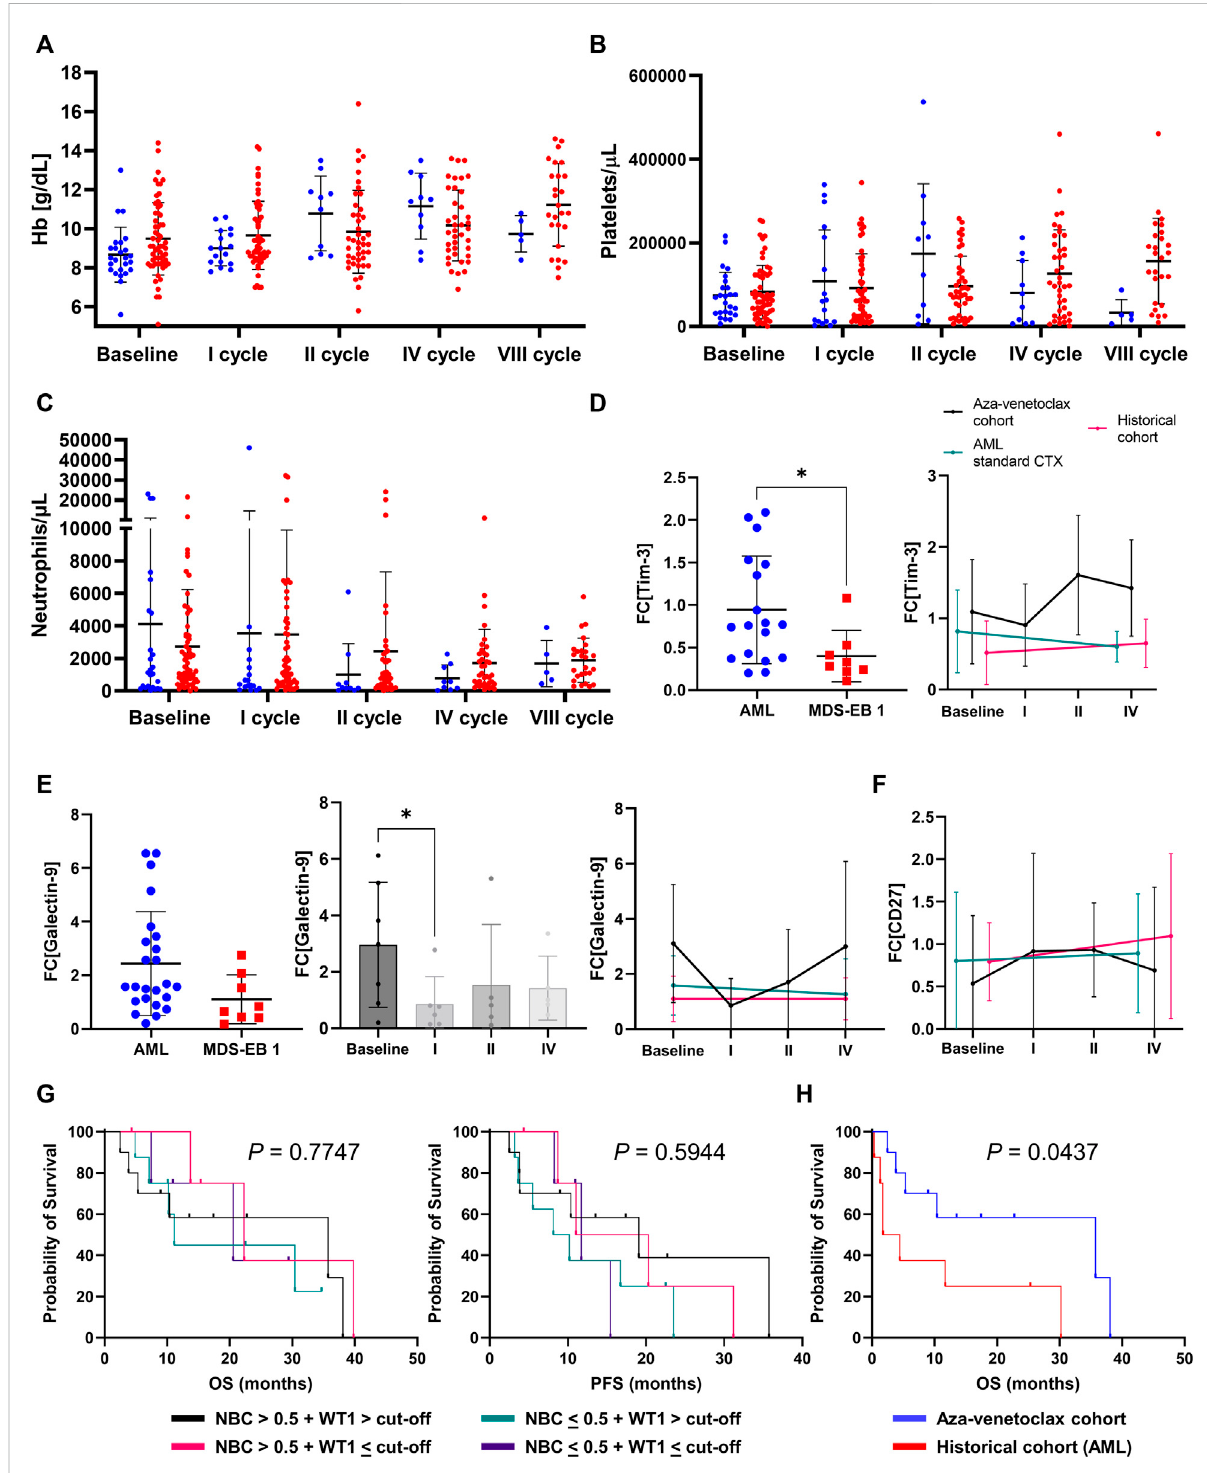
FIGURE 3 Laboratory parameters and prognosticators (A) hemoglobin (Hb) levels (B) platelets count, and (C) absolute neutrophil count variations at baseline and during treatment in azacytidine plus venetoclax (aza-venetoclax cohort) or to azacytidine as single agent (historical cohort) groups are reported (D) differences inTim-3 expression [reportedas fold-change(FC) to healthy controls] based ondisease[acutemyeloid leukemia (AML) and high-risk myelodysplastic syndromes (MDS) vs. MDS with excess of blast of type 1 (MDS-EB 1)] or treatment type [azacytidine + venetoclax vs. azacytidine alone vs. standard chemotherapy (CTX)]. Similarly (E) galectin-9 and (F) CD27 FC variations are displayed based on disease type and during treatment (G) Overall survival (OS) and progression-free survival (PFS) are reported for patients treated with azacytidine plus venetoclax divided by normalized WT1 expression levels and fl ow cytometric normalized blast count (NBC) values (H) OS of patients with WT1 > cut-off (50 copies in peripheral blood or 250 copies in bone marrow) + NBC > 0.5 were compared between aza-venetoclax and historical AML